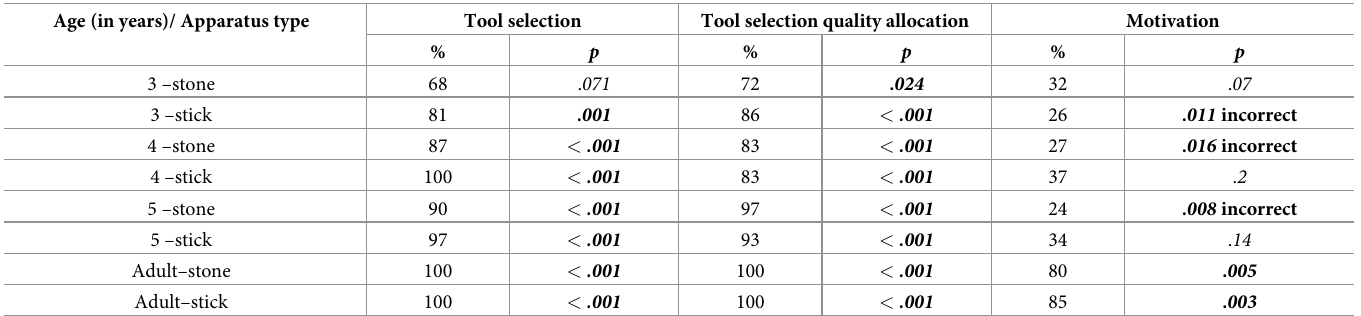
Table 2. Correct choices (%) in tool selection, tool selection quality allocation and motivation conditions within each apparatus type for each age (3–5 years) for children and for adult humans. P-values calculated from exact two-tailed binomial tests. Significant p-values are highlighted in bold. NS = not significant with a Bonfer- roni correction. “Incorrect”–selected incorrect choice above